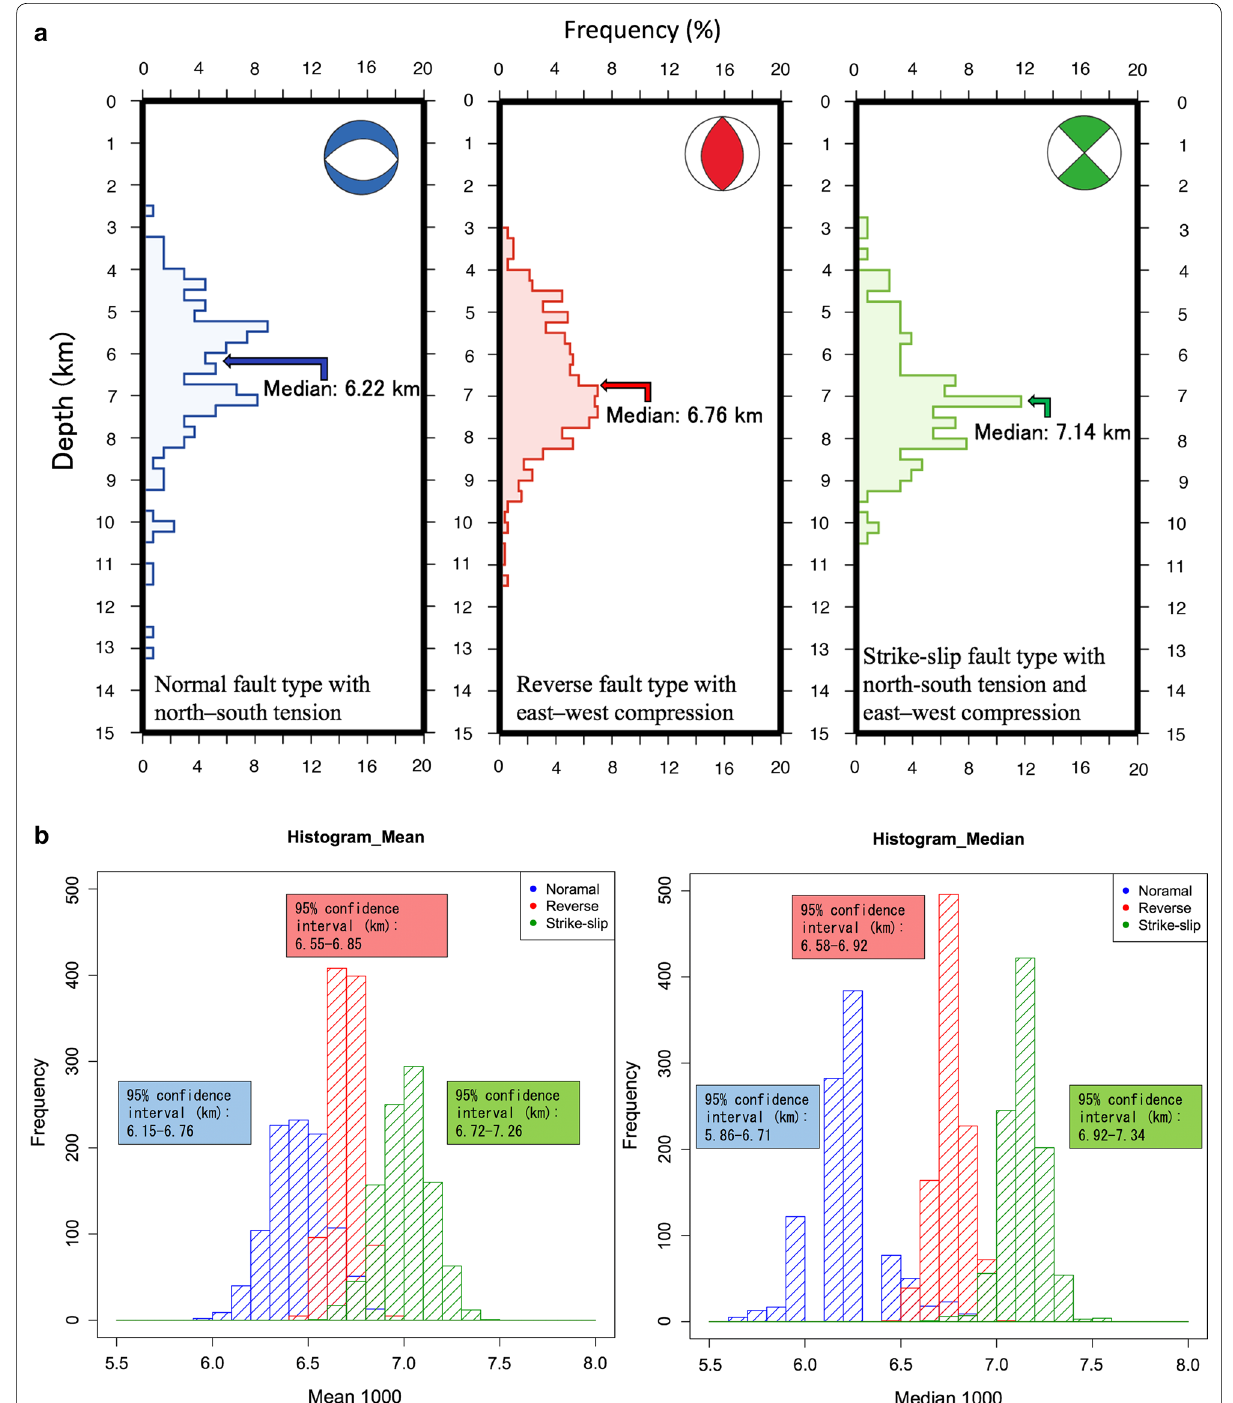
Fig. 8 Depth distribution of each faulting type. a Histograms of the depths for respective faulting types. Blue, red, and green histograms corre- spond to normal, reverse, and strike-slip focal mechanisms, respectively. Median depths for respective mechanisms are indicated by arrows. b Bootstrap sample distributions of the averages (left) and medians (right) of the depths for respective faulting types. Confidence intervals of 95% are also shown in the boxes. Bootstrap resamplings were carried out 1000 times. The lack of the medians for 6.01–6.10 and 6.31–6.40 km ranges is due to the accidental lacks of the original data in these ranges. In this study area, most of the focal mechanisms are categorized into these three groups, and the predominant depth differs among the groups: (1) N–S tensional normal fault-type events mainly occur in the shallower part, (2) E–W compressional reverse-fault-type events dominate at intermediate depths, and (3) N–S tensional and E–W compressional strike-slip-fault-type events mainly occur at the greatest